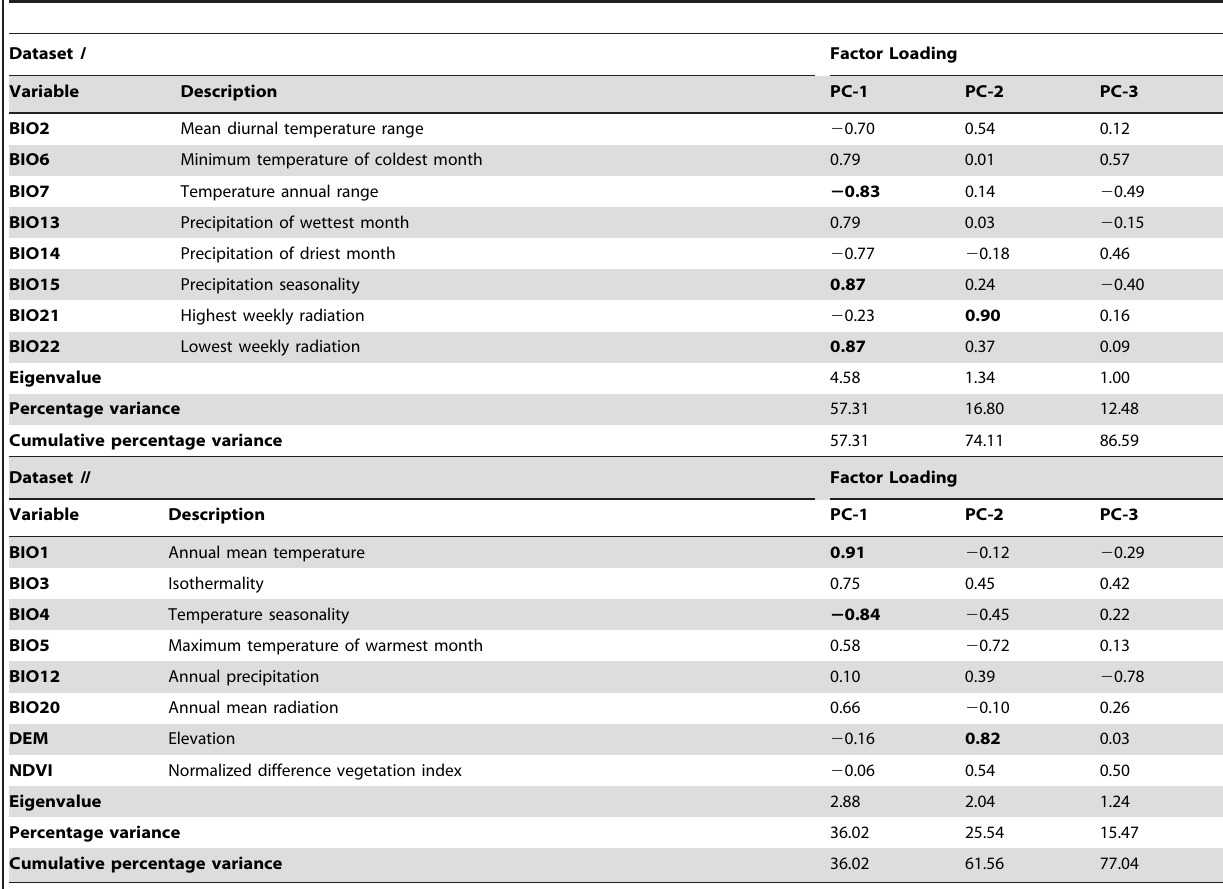
Table 1. Principal components analysis (PCA) of environmental variables associated with occurrence of Bean